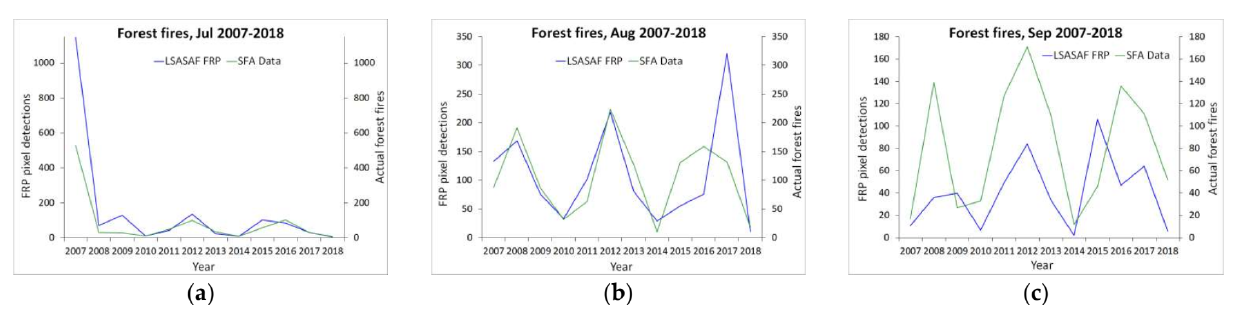
Figure 4. Inter-annual dynamics of forest fires over Bulgaria according the LSASAF FRP-Pixel product detections (blue line) and ground observations of actual forest fires by the national SFA (green line) for ( a ) July, ( b ) August, ( c ) September 2007–2018.